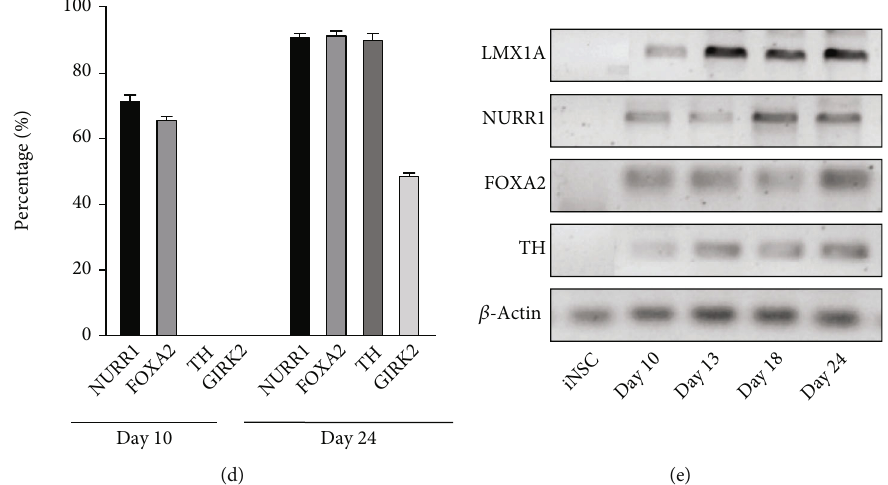
Figure 3: Di ff erentiation of iNSCs into midbrain dopamine neurons with high e ffi ciency in vitro. (a) Flow chart of the di ff erentiation of iNSCs into DA neurons in vitro. (b) Representative pictures of cells at di ff erent di ff erentiation time points. (c) Immuno fl uorescence staining for NURR1 and FOXA2 on cells of di ff erentiation day 10 (scale bars, 50 μ m) and for TH and GIRK2 on cells of di ff erentiation day 24 (scale bars, 75 μ m). (d) Quanti fi cation of positive cells for each marker. (e) Expression of LMX1A, NURR1, FOXA2, TH, and β - actin at the transcription level in iNSC-GFP before di ff erentiation and at di ff erentiation days 10, 13, 18, and